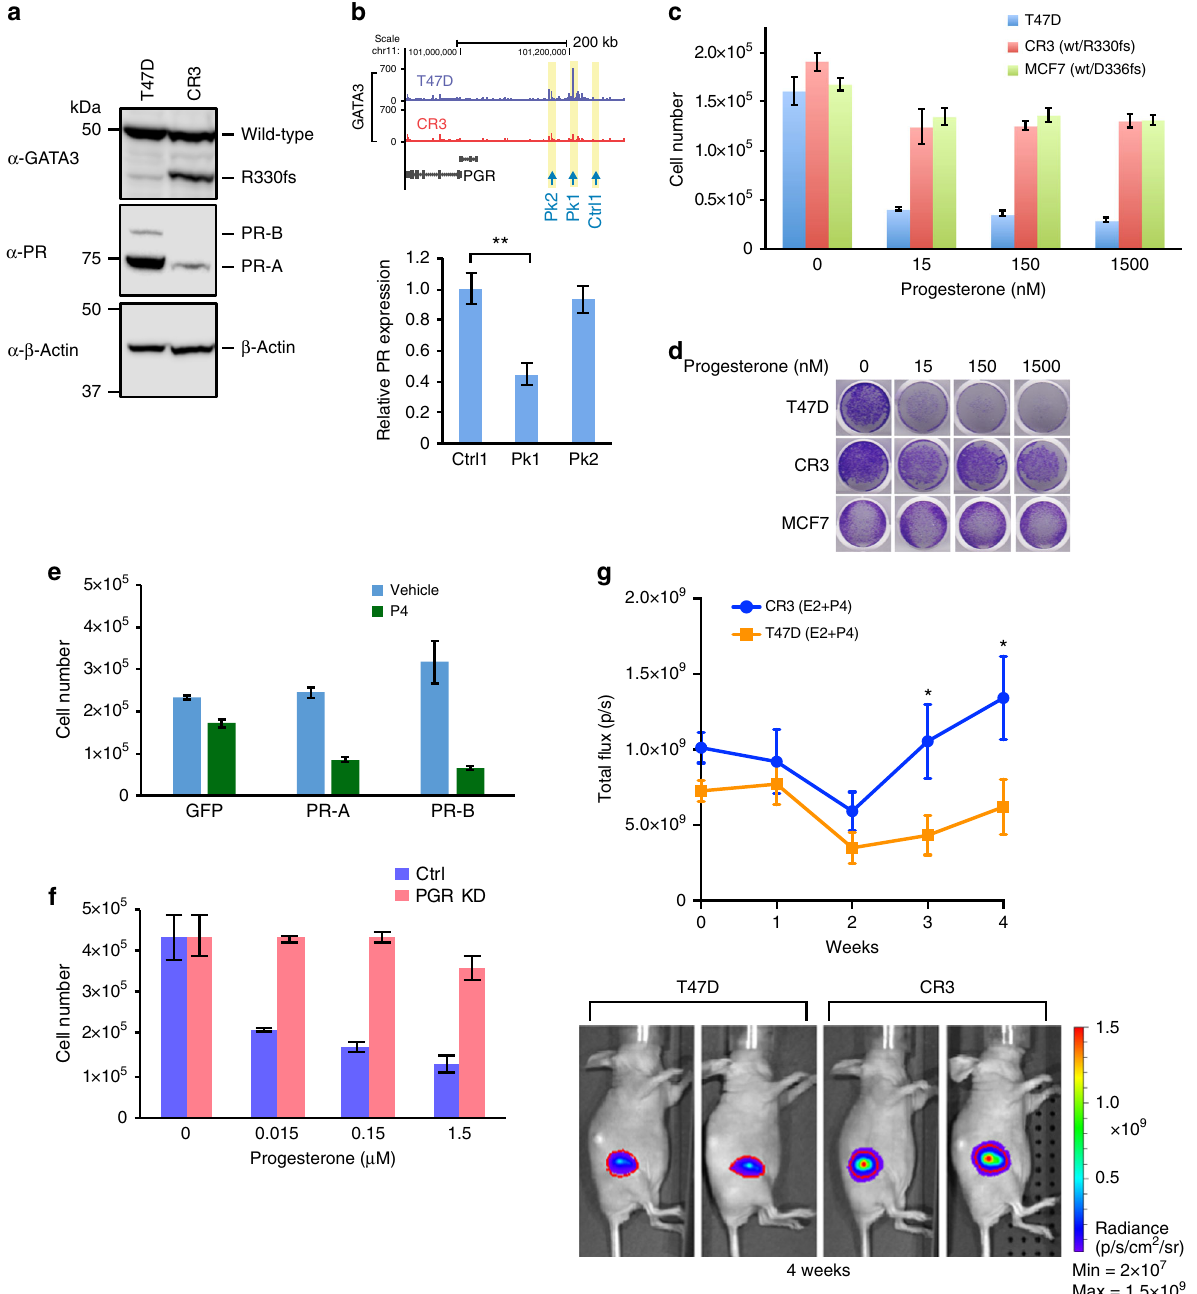
Fig. 6 ZnFn2 mutant cells exhibit low PR expression, and growth advantage in the presence of progesterone. a Immunoblots showing the expression level of GATA3 (top), PR-B, and PR-A (middle, Cell Signaling). β -actin levels (bottom) are shown as a loading control. b PR gene expression analysis in the GATA3-peak depleted cells by CRISPR – Cas9. Relative expression was calculated by the delta – delta Ct method. ** p < 0.01, unpaired t -test. c Cell proliferation analysis of GATA3-mutant cells in the presence of progesterone. Data are presented as mean with SD. d Representative images of cell proliferation analysis. The cells are stained with crystal violet after the treatment with indicated concentration of progesterone. e Cell proliferation analysis of CR3 cells transduced with PR-A and PR-B expression vectors. f Cell proliferation analysis of PR knockdown cells in the presence of progesterone. g Tumor growth analysis by mouse xenograft experiments. Estrogen and progesterone pellets were implanted subcutaneously 1 week prior to cell injection, which was de fi ned as time zero. Data are shown as mean with SEM ( N > 10). * p < 0.05, unpaired t